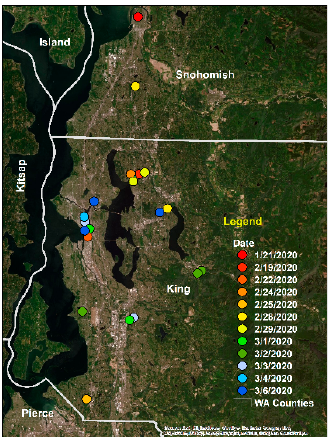
Figure 5. Proxy locations of COVID-19 cases in Snohomish and King Counties in WA from 21 January